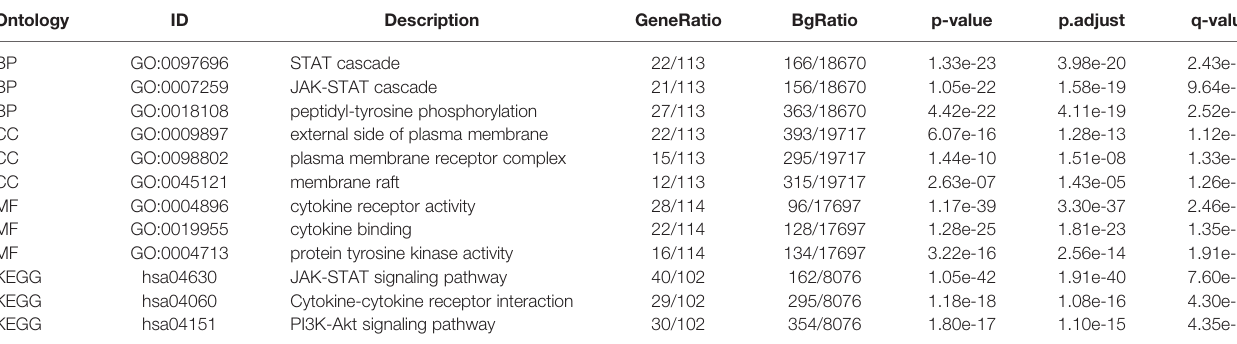
TABLE 3 | GO and KEGG enrichment analysis of SOCS3 and their